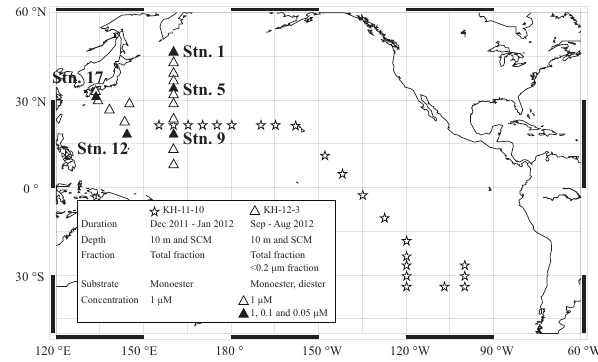
Fig. 1 Fig. 1. Station location. Different symbols indicate different cruises. Kinetic assay experiments were conducted at the five stations indi- cated by solid